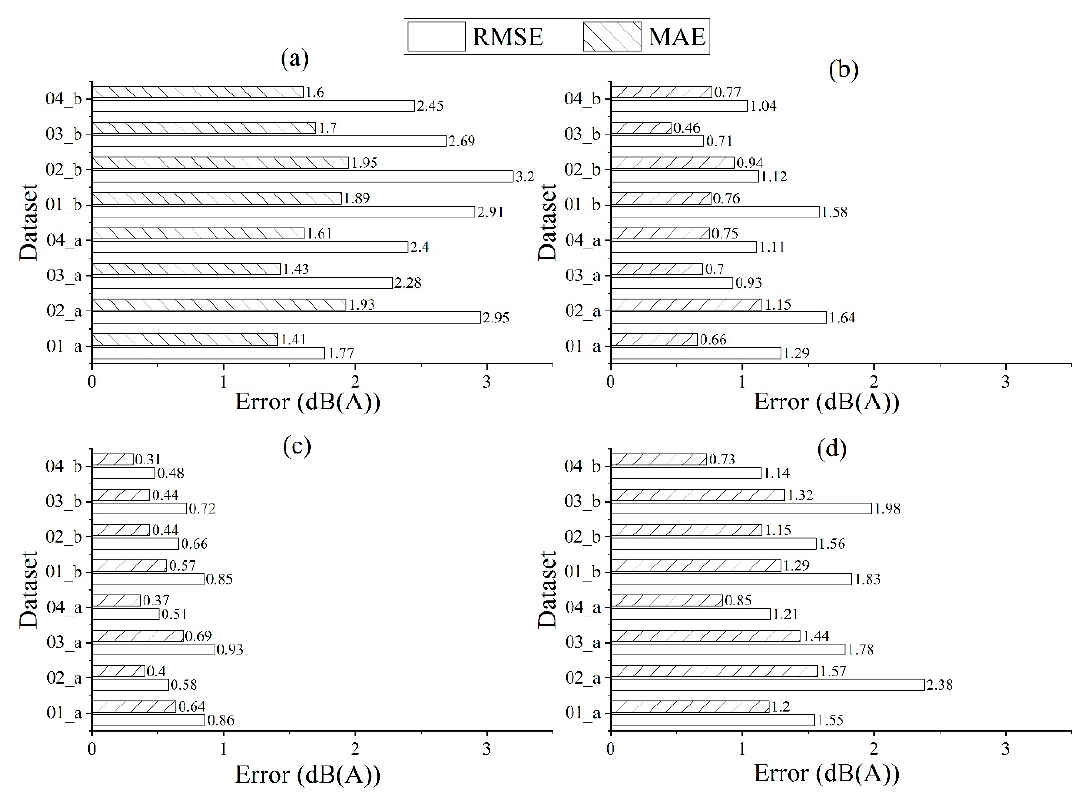
Figure 6. Model performance on different time interval datasets: ( a ) 1-s interval; ( b ) 1-min interval; ( c ) 10-min interval; ( d ) 30-min interval.